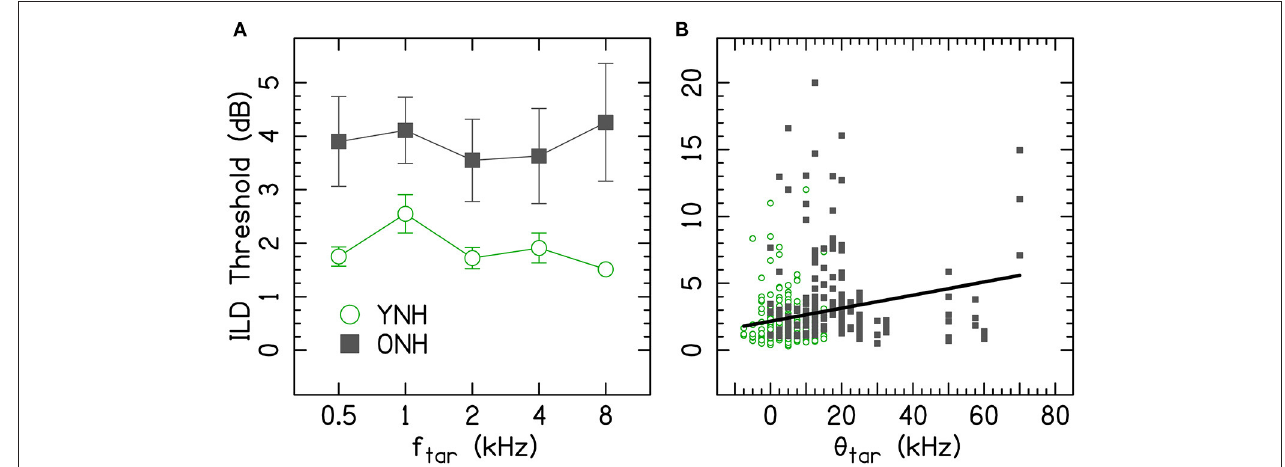
FIGURE 2 | (A) Average ILD thresholds for single tones. Error bars represent ± 1 standard error of the listener mean. (B) Individual ILD thresholds for single tones as a function of hearing threshold ( θ tar ). f tar , target frequency; ONH, older normal hearing; YNH, younger normal hearing; θ tar , average interaural hearing threshold at the target frequency. The YNH data have been previously reported. Reproduced from Beth Rosen and Matthew J. Goupell, “The effect of target and interferer frequency on across-frequency binaural interference of interaural-level-difference sensitivity,” J. Acoust. Soc. Am. 151, 924–938 (2022), https://aip.scitation.org/doi/10.1121/10. 0009398, with the permission of Acoustical Society of America.